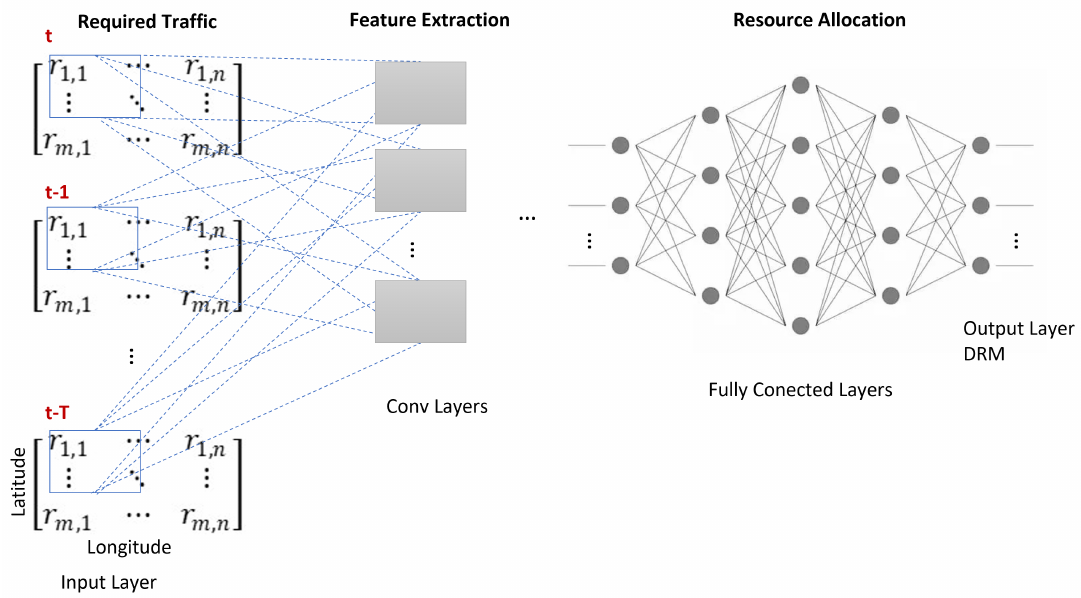
Figure 6. Convolutional Neural Network (CNN) to manage power, bandwidth and beamwidth